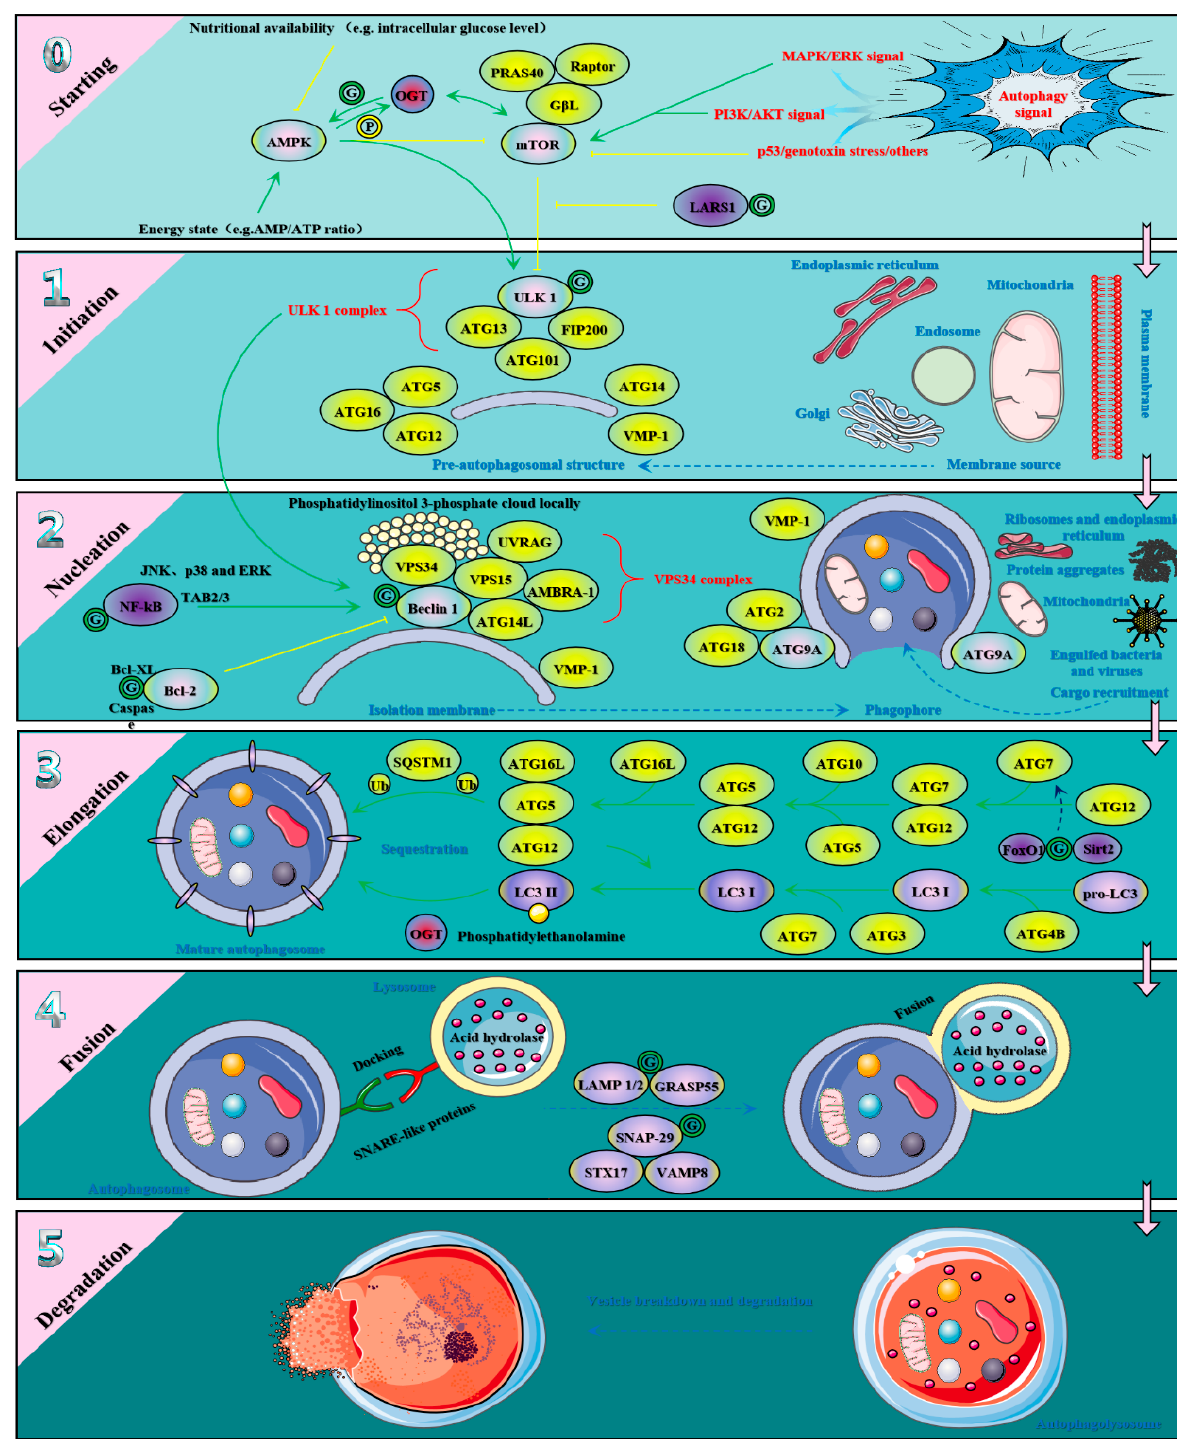
Figure 4. The main target of O -GlcNAcylation involved in autophagy process of skeletal muscle. O -GlcNAcylation is involved in almost all processes of autophagy including initiation, nucleation, expansion and fusion in addition to degradation. First, there is extremely extensive crosstalk between O -GlcNAcylation and autophagic signal transduction. Activation of AMPK in response to energy deprivation inhibits mTOR and activates ULK1. Acute activation of AMPK alters the substrate selectivity and nuclear localization of OGT in myotubes, which is closely related to the phosphorylation of OGT at Thr 444 by AMPK. In contrast, OGT catalyzes the O -GlcNAcylation of α and γ subunits of AMPK, and these modifications increase with increasing AMPK activity. There is crosstalk between O -GlcNAcylation and mTOR signaling including their mutual regulation of each other’s stability. Meanwhile, OGT regulates autophagy gene expression and autophagy structure through AKT and FoxO3. At the initiation of autophagy, ULK1-ATG13-ATG101-FIP200 complex and vacuolar protein sorting (VPS34)-Beclin 1 complex coordinate to drive the formation of isolation membrane, which is inhibited by mTORC1 and inactivated by Bcl-2 inactivates, respectively. O -